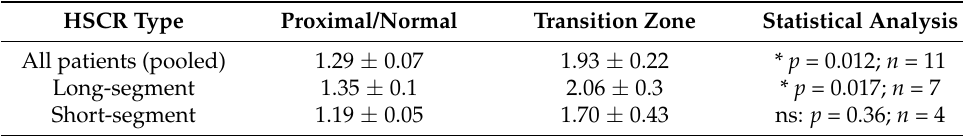
Table 2. Muscle unit to ganglion ratios. HSCR Type Proximal/Normal Transition Zone Statistical Analysis All patients (pooled) 1.29 ± 0.07 1.93 ± 0.22 Long-segment 1.35 ± 0.1